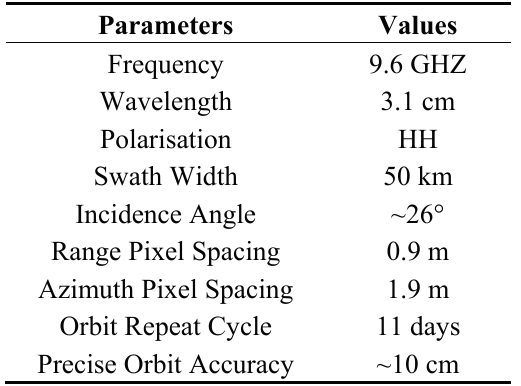
Table 1. TerraSAR-X Parameters used in this study.